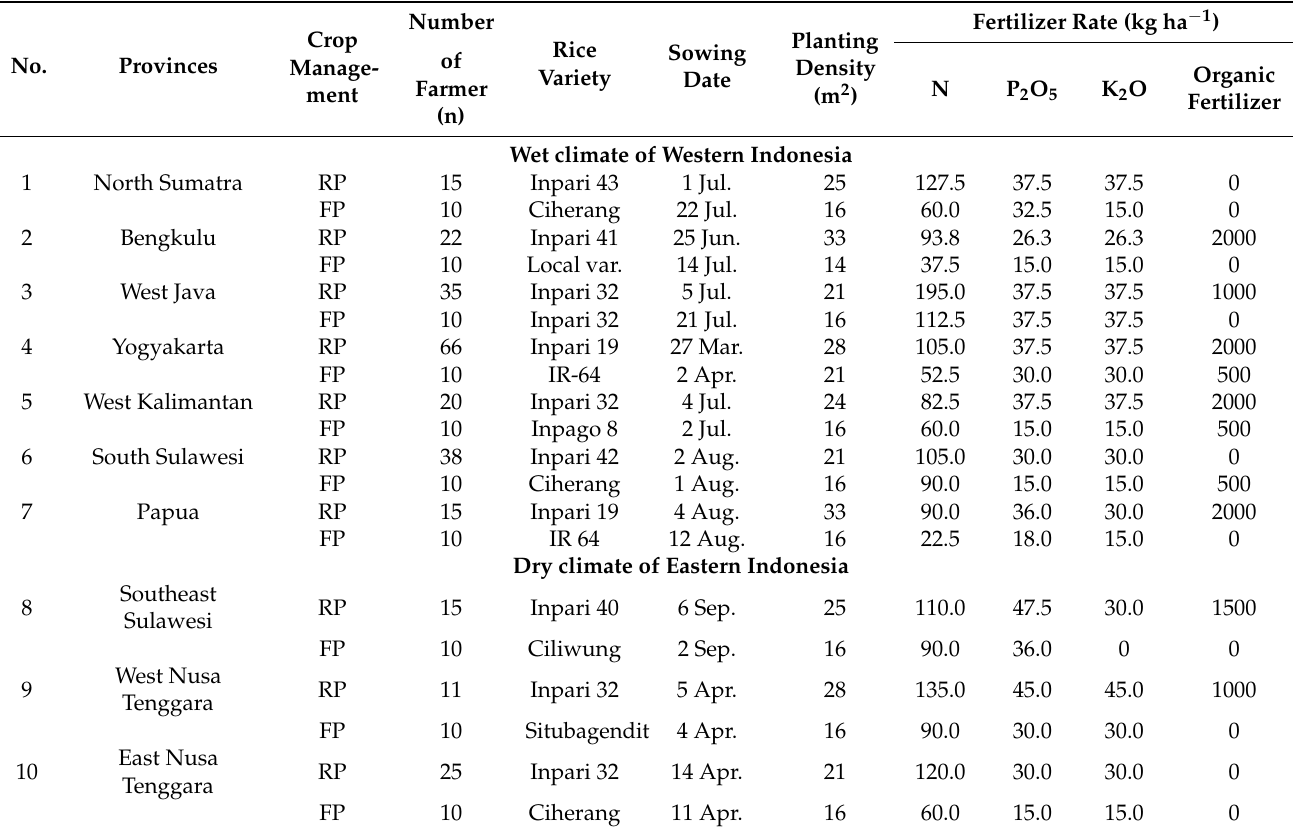
Table 4. Integrated crop and nutrient management practices designated as recommended practices based on site-specific variety and nutrient management for rainfed lowland rice in ten provinces in Indonesia, dry season (DS)